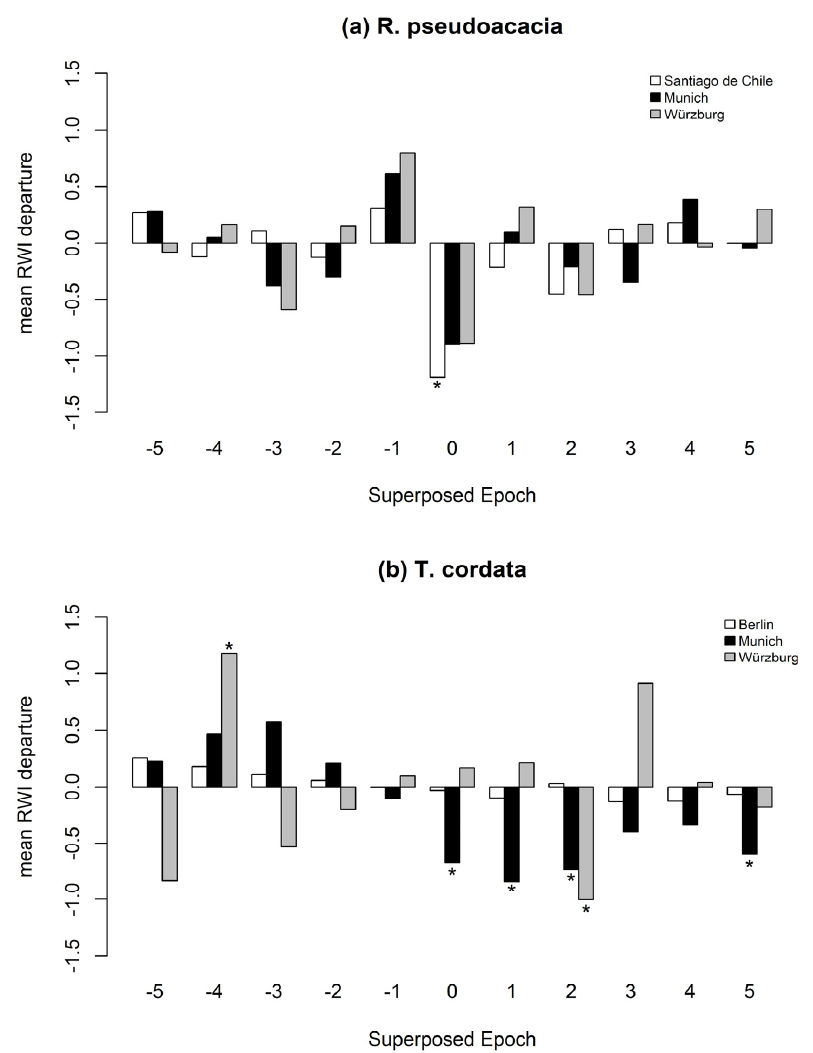
Figure 7. Superposed epoch analysis on the influence of drought years in the RWI of R. pseudoacacia ( a ) in Santiago de Chile (white bars), Munich (black bars) and Würzburg (grey bars), and T. cordata ( b ) in Berlin (white bars), Munich (black bars) and Würzburg (grey bars). Shown are RWIs during drought years (0), pre-drought ( − 5 to − 1), and post-drought years (1 to 5). Significant RWIs ( p < 0.05) are marked by *.